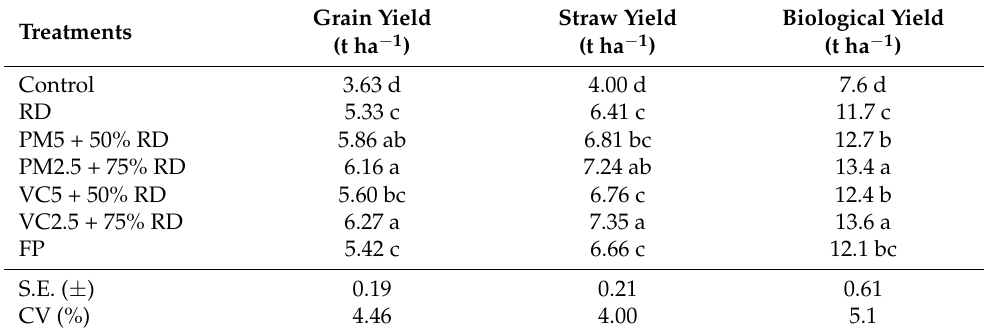
Table 1. The yield of rice under different treatments of organic manures and inorganic fertilizers. Grain Yield Treatments